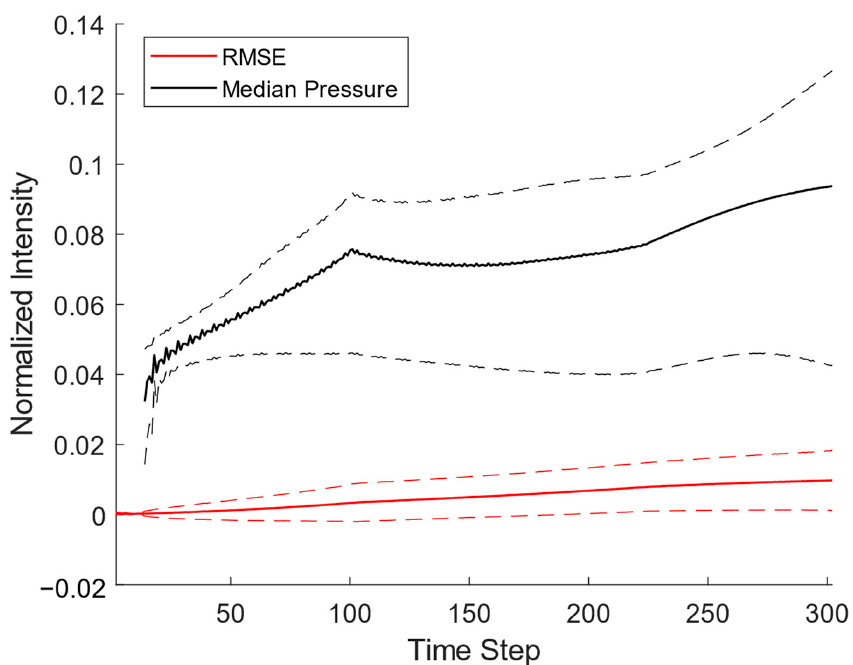
Figure 10. RMSE and standard deviation bands between the k-Wave and FNO adjoint simulations for the AWA2 test dataset. Distribution of pressures (25th, 50th and 75th percentiles) is provided as a frame of reference.